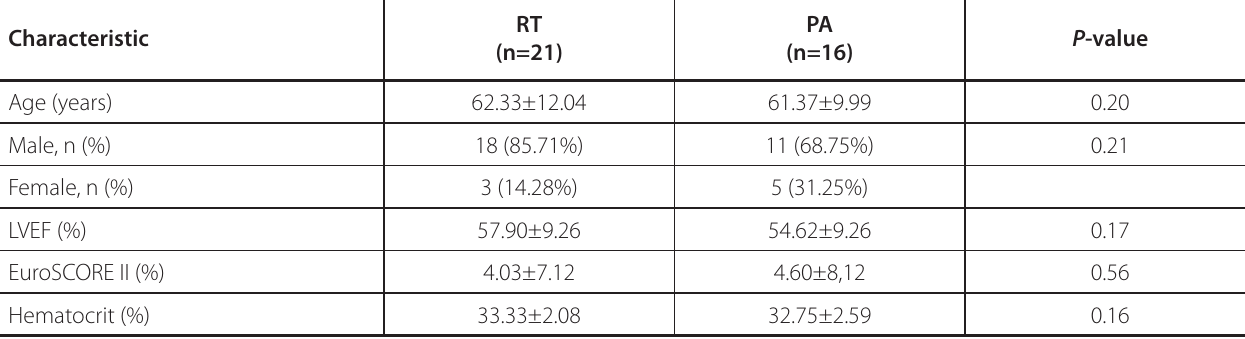
Table 1 . Baseline characteristics of patients who underwent MIS mitral valve repair via RT and PA.